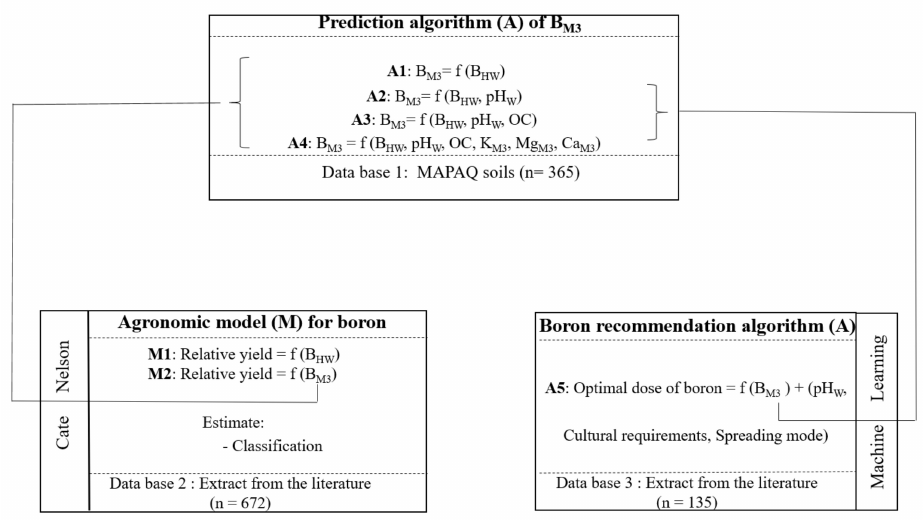
Figure 1. Summary of the di ff erent steps in the development of the models for the diagnosis and recommendation of boron in acidic to neutral soils. B M3 : Boron Mehlich-3; B HW : Boron hot water; pH W : pH water; OC: Organic carbon; K M3 , Mg M3 , and Ca M3 are, respectively, Mehlich-3 extracted potassium, magnesium and calcium; MAPAQ: Ministry of Agriculture Fisheries and Food of